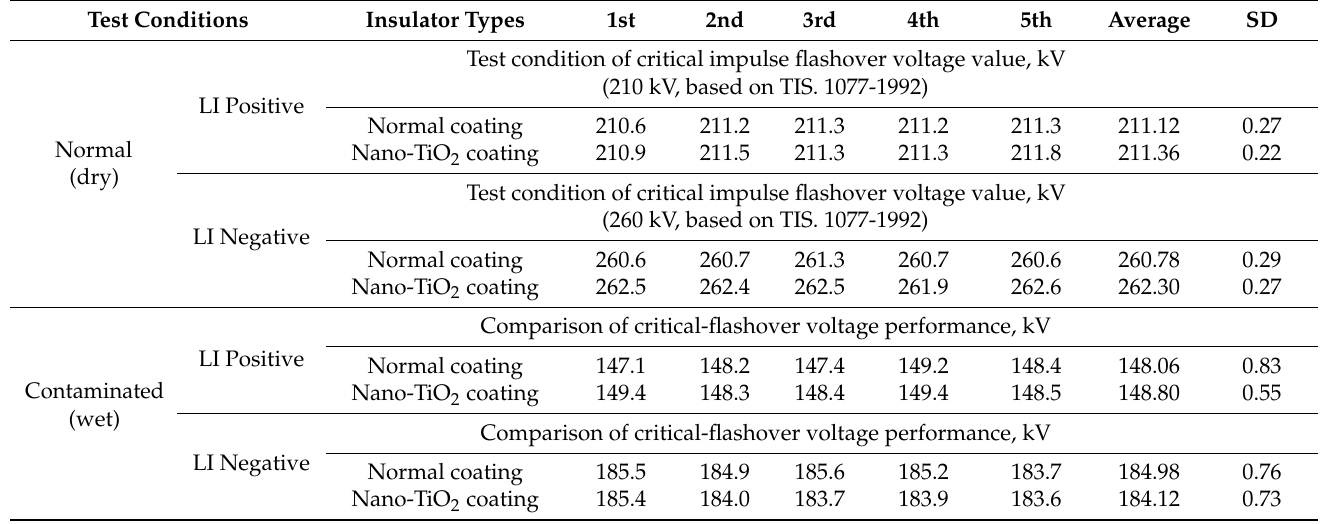
Table 3. Test results of critical impulse flashover voltage value under normal and contaminated test conditions.